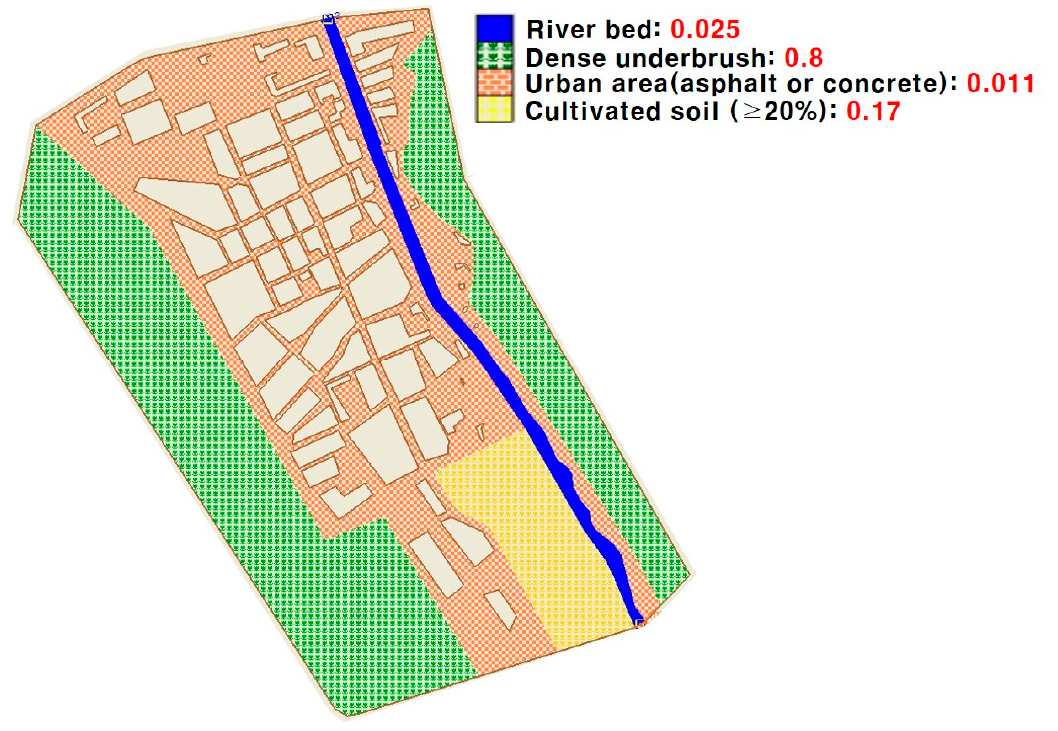
Water 2019 , 11 , x FOR PEER REVIEW Figure 6. Distribution of Manning’s roughness coefficients with land use. Figure 6. Distribution of Manning’s roughness coe ffi cients with land use.